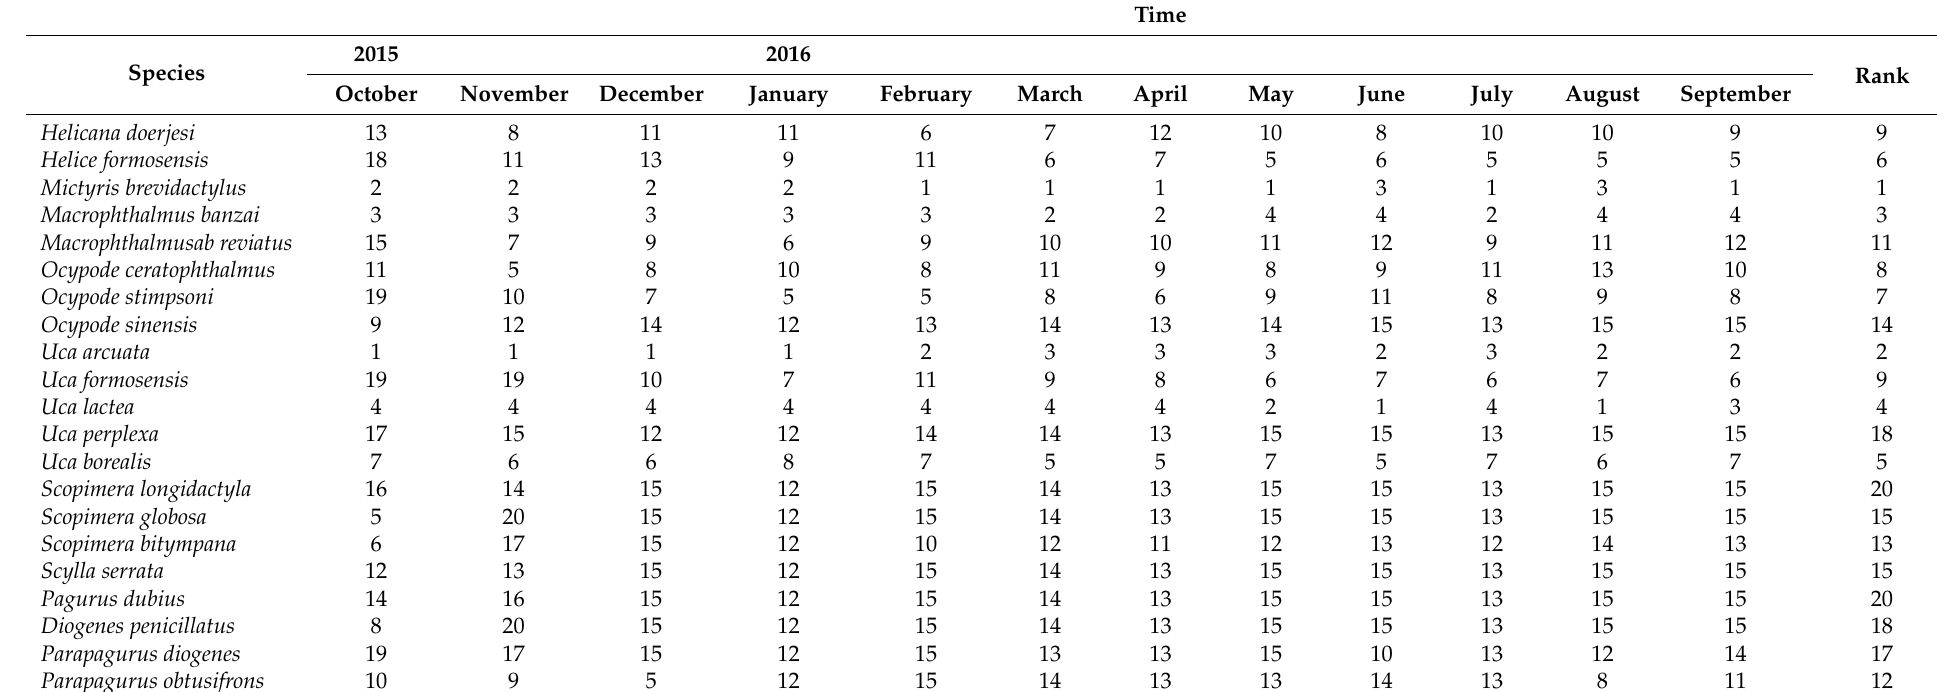
Table A5. Monthly rankings in terms of probability of contributing to biodiversity ( D c.k.m.